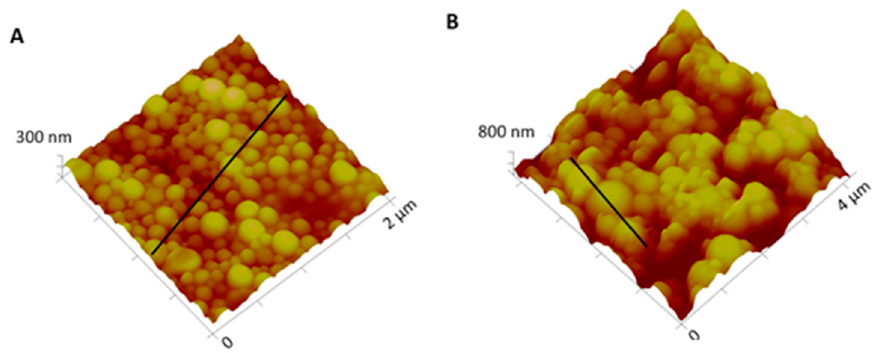
Figure 2. Three-dimensional atomic force microscopy (AFM) topography images and corresponding profiles: ( A ) Empty NPs and ( B ) insulin-loaded NPs.